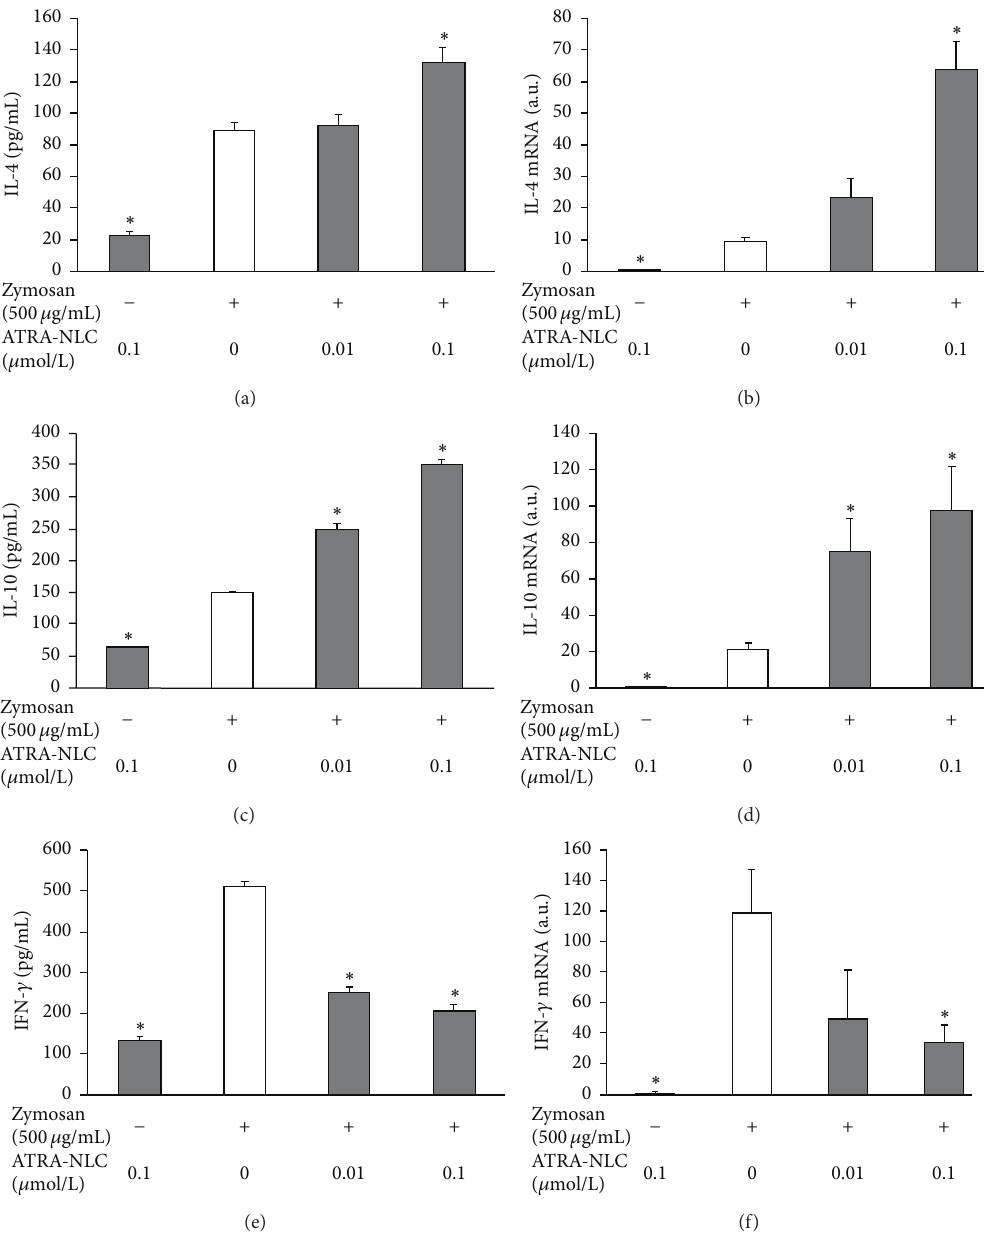
Figure 2: Effect of ATRA-NLC on the expression of IL-4, IL-10, and IFN- 𝛾 from RCFs and in RCFs. (a), (c), and (e) Serum-deprived RCFs were incubated in the absence or presence of ATRA-NLC with or without zymosan for 24 h. The IL-4, IL-10, and IFN- 𝛾 concentrations were examined at 24 h with a cytokine assay system. Zymosan can induce IL-4, IL-10, and IFN- 𝛾 release. ATRA-NLC further increased the release of IL-4 and IL-10 and decreased the release of IFN- 𝛾 . Data are the mean values ± SDs of three experiments. ∗ 𝑃 < 0.01 versus the corresponding value for cells cultured with zymosan (Dunnett T3). (b), (d), and (f) RCFs were incubated in the absence or presence of the indicated concentrations of ATRA-NLC and zymosan, after which total RNA was isolated and subjected to RT and real-time PCR analysis of IL-4, IL-10, and IFN- 𝛾 mRNAs. Incubation of the cells with ATRA-NLC and zymosan induced the expression of IL-4 and IL-10 and decreased the expression of IFN- 𝛾 in a concentration-dependent manner. Data are the mean values ± SDs of three experiments. ∗ 𝑃 < 0.05 versus the corresponding value for cells cultured with zymosan (Dunnett